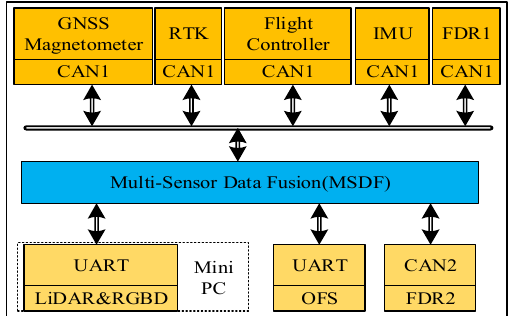
Figure 2. The modules of the system communicate in real time through the Controller Area Network (CAN) bus and the Universal Asynchronous Reciever/Transmitter (UART) bus.